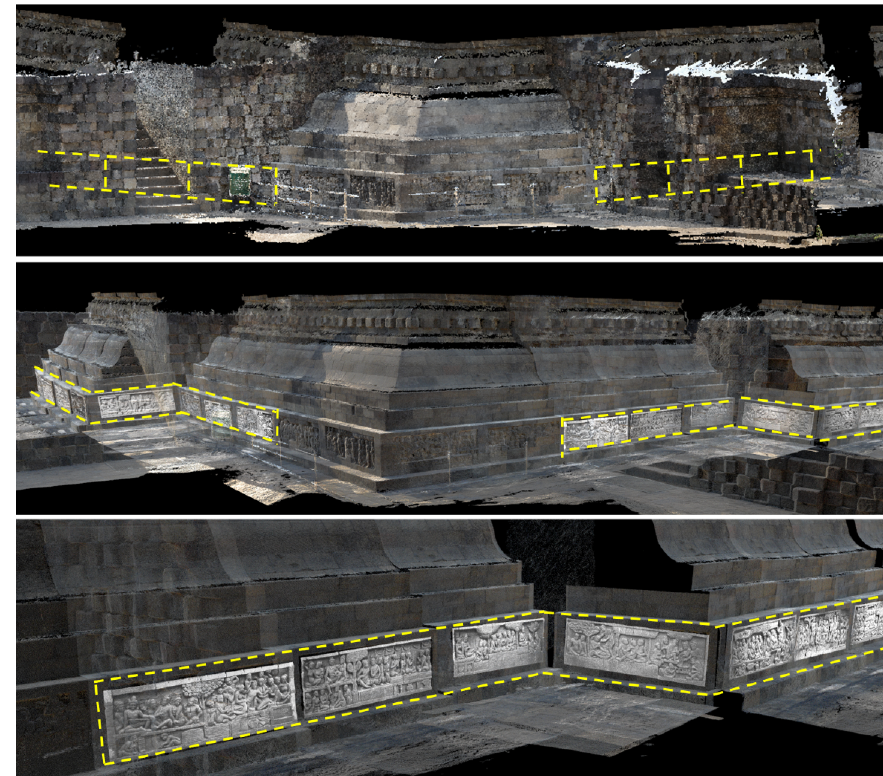
Figure 19. The zoom-in transparent visualization results of the hidden